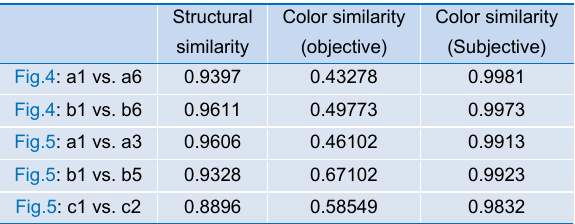
Table 1 | Evaluation of experimental and design images Structural